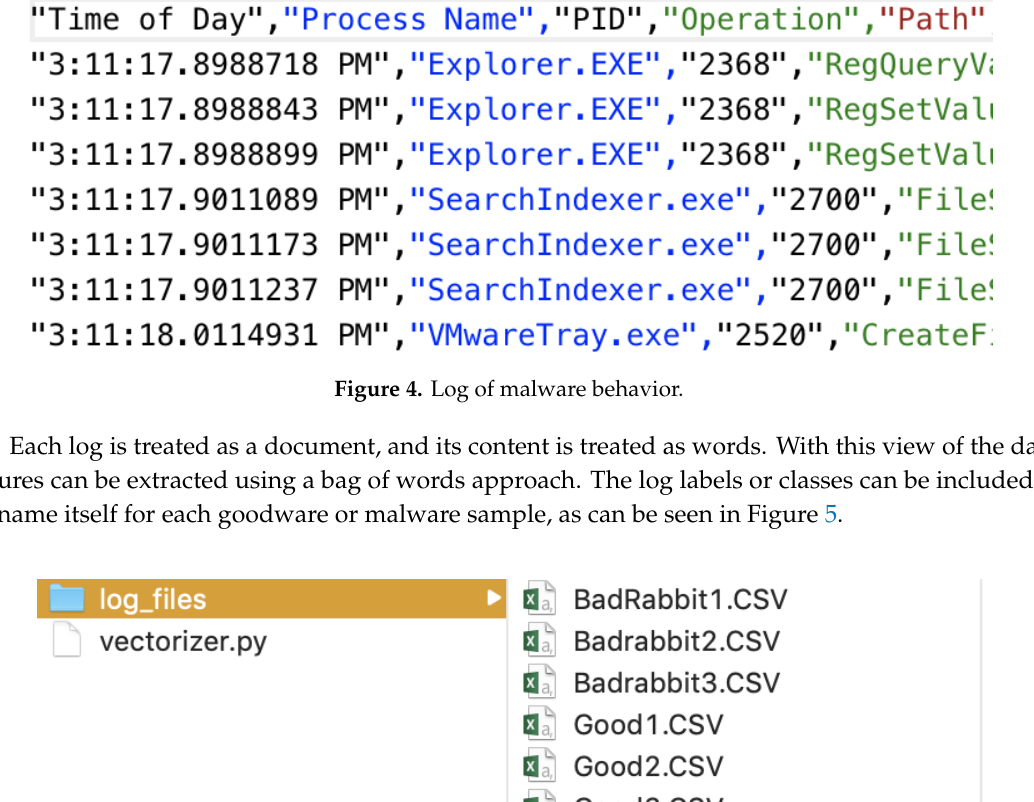
Figure 6. Initialization of CountVectorizer.